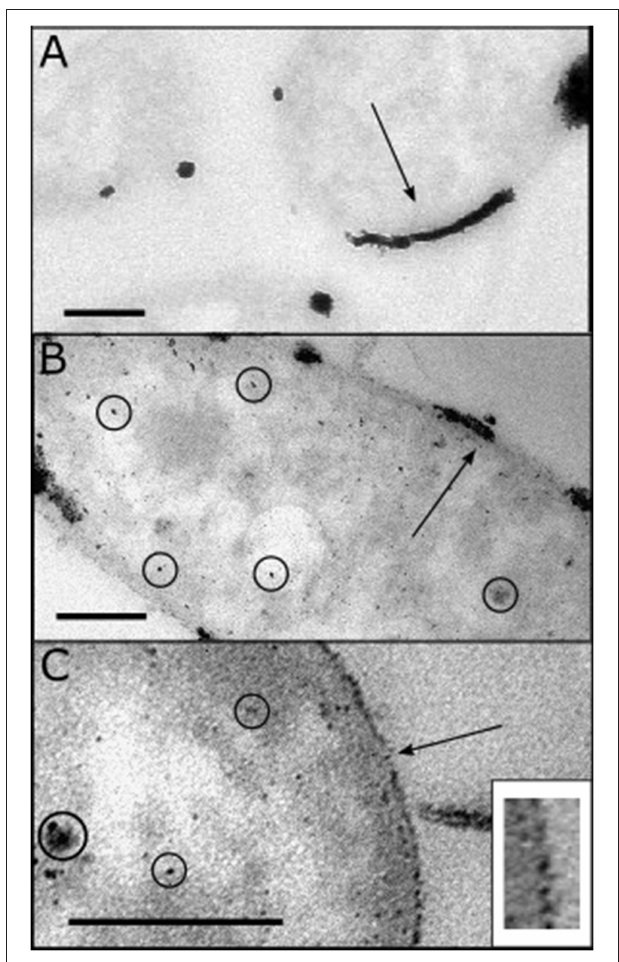
FIGURE 4 | TEM images taken of E. coli -NP catalysts fixed and sectioned as detailed in Materials and Methods. (A) adapted from Williams (2015), shows E. coli -Pt (10%) where agglomerated periplasmic Pt NPs are identified with a black arrow (c.f. 5 wt% Bio-Pd in Figure 3B ); note lack of intracellular NPs using equimolar Pt. (B,C) show E. coli -Pt/Pd (10%:10%) where the black arrow shows a degree of agglomeration at the periplasm, while intracellular nanoparticles can be seen (circled). The higher magnification image (C) shows a “nanoparticle shell” in the periplasm as indicated by the black arrow. Bars are 200nm. Inset: expanded region of the cell surface of the cell shown in (C) , showing discrete supported NPs.